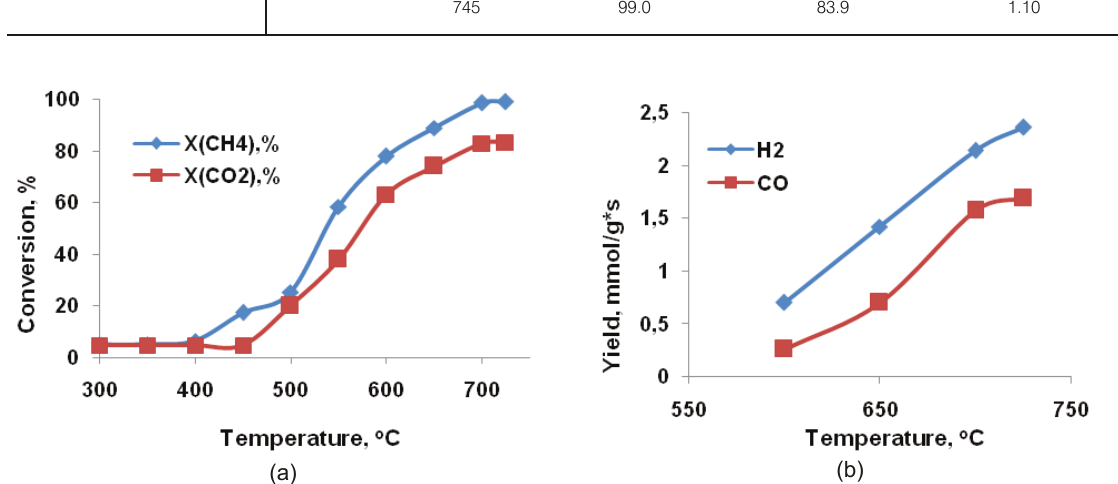
Figure 2. Effect of temperature on the steam reforming of biogas over the 5%(Co-M